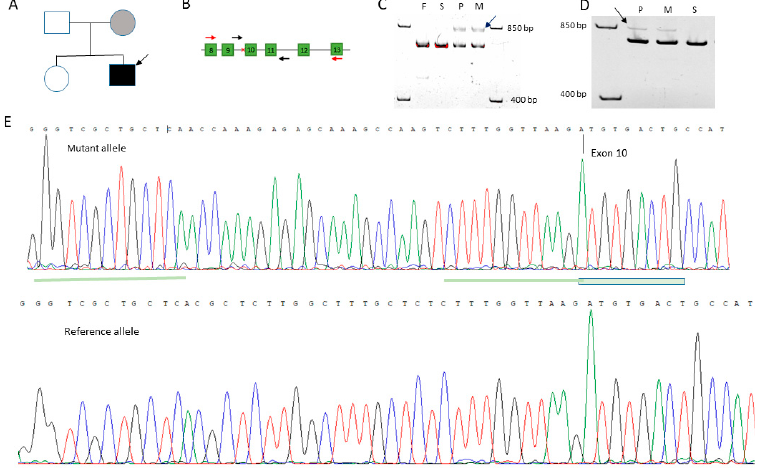
Figure 2. ( A ) The diagram of the investigated family. ( B ) The GNAS gene scheme (8–13 exons) with primer locations for the mutation detection (in black) and cDNA sequencing (in red). ( C ) Polyacrylamide gel image of the exon 10–11 amplicon of the GNAS gene from DNA. Arrow indicates a heteroduplex of the mutant and reference alleles. ( D ) Polyacrylamide gel image of the exon 8–13 amplicon of the GNAS gene from cDNA. Arrow indicates an additional variant found in the samples. ( E ) Sanger sequence trace of mutant and reference alleles. The green line under the mutant allele indicates overlapping regions. The red line under the reference allele denotes an inversion. The black dotted line denotes a deleted region.